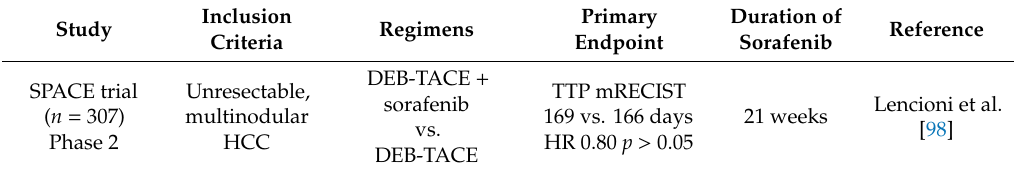
Table 1. Randomized trials evaluating Sorafenib concomitant to TACE. TTP: time to progression; HCC: hepatocellular carcinoma; DEB-TACE: drug-eluting bead TACE; TACE: